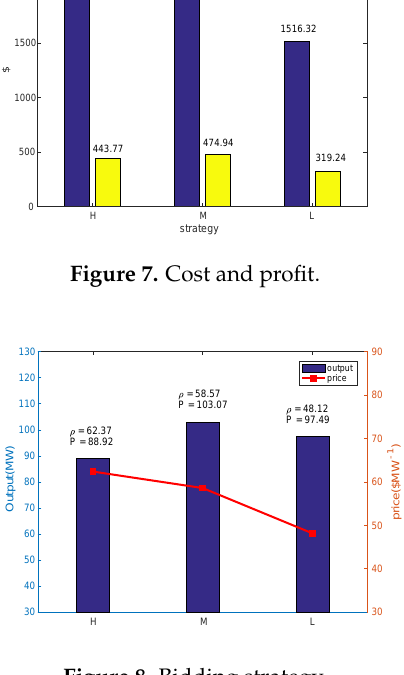
Figure 8. Bidding strategy.